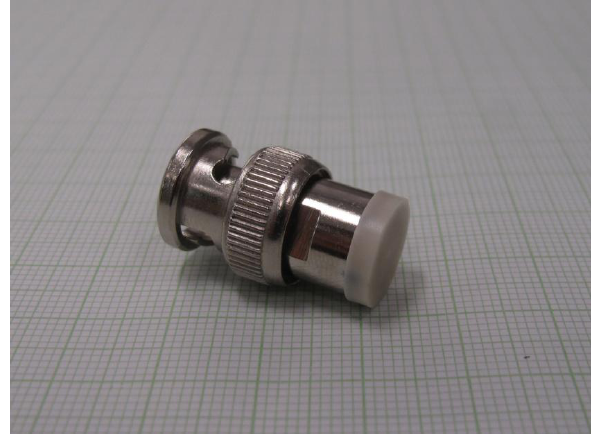
Figure 13. Photograph of the 1-3 composite single-element ultrasonic transducer (with permission from [79]).